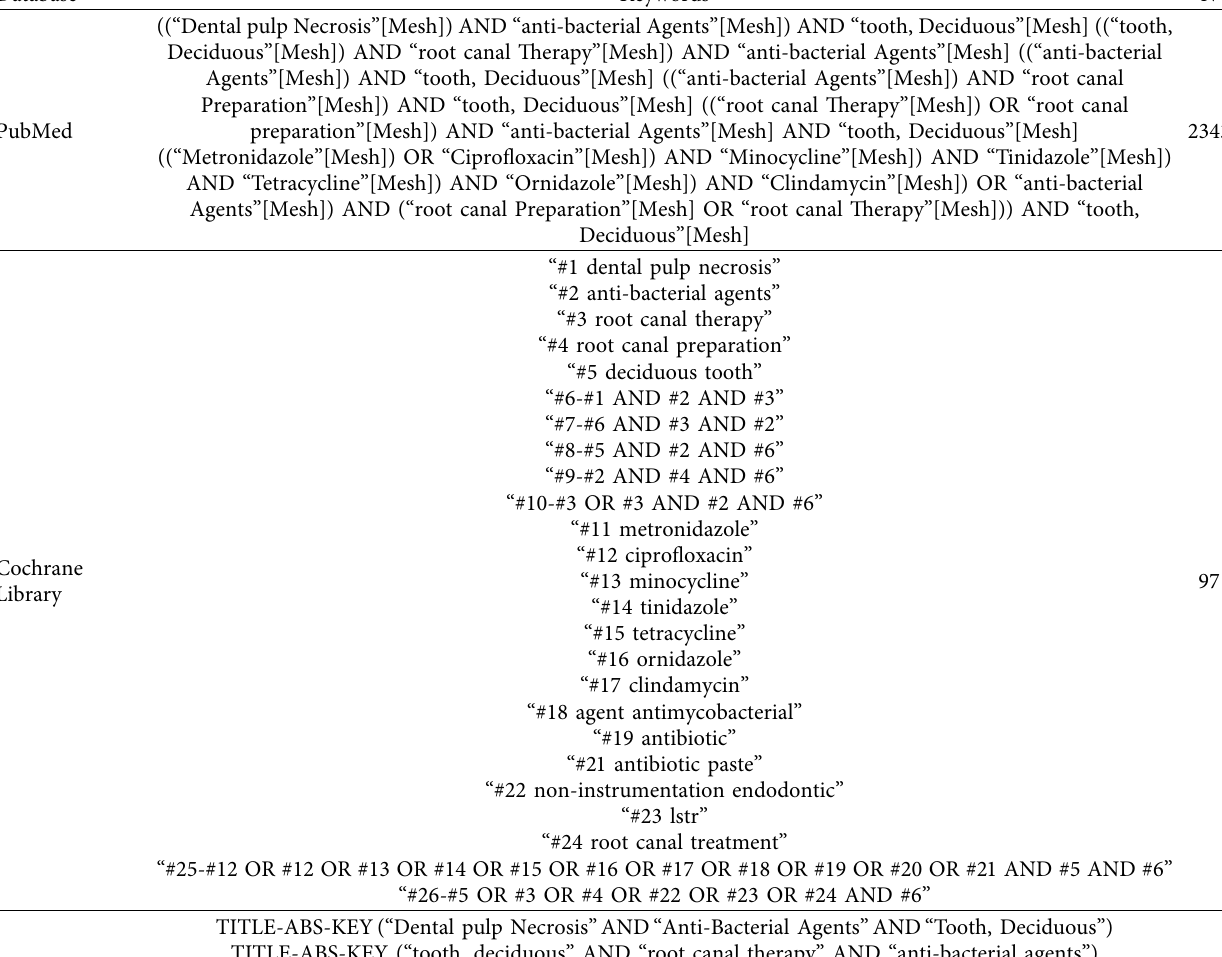
Table 1: Keywords used to develop the search strategies.